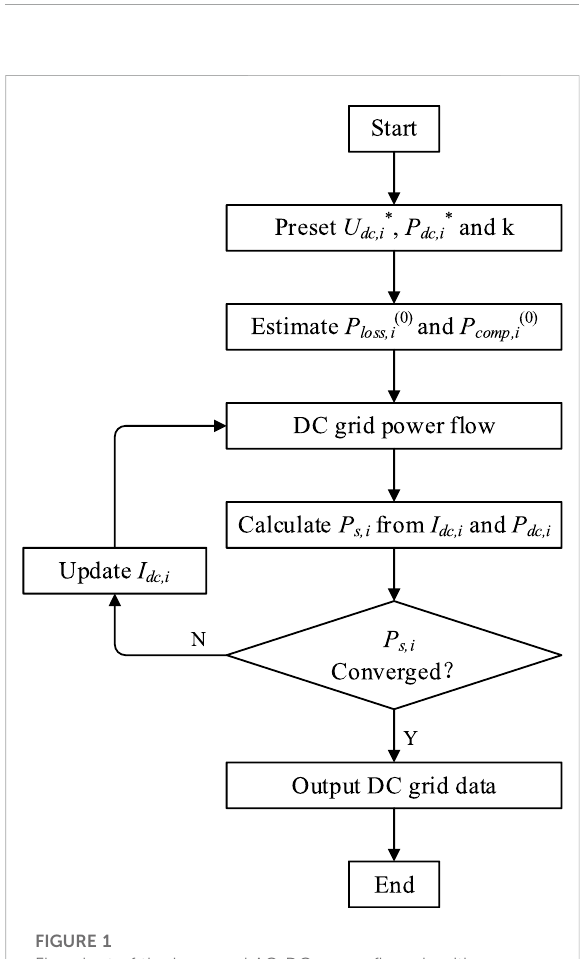
FIGURE 1 Flowchart of the improved AC-DC power fl ow